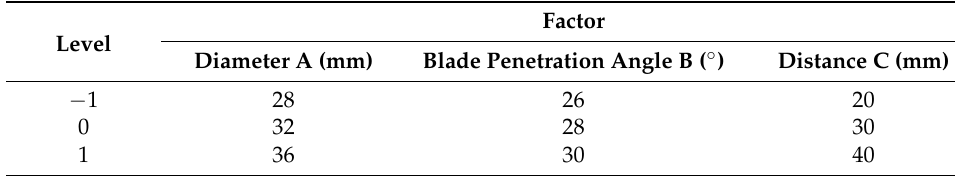
Table 2. The test factor level coding table.